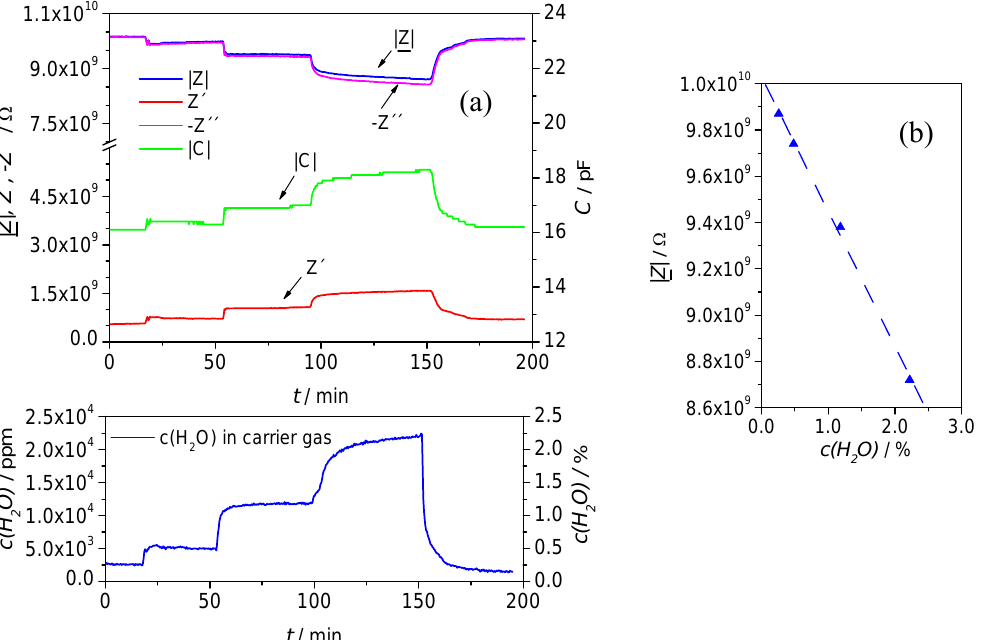
Figure 7. (a) Upper part: Impedimetric sensor signal (| Z |, Z´, -Z´´, C) of an IDE equipped with Fe-BTC in time-continuous measurements at 1 Hz for 0 - 2.5 vol%H Lower part: H O concentration in the test gas over time evaluated by FTIR. (b) Response 2 curve of the sensor (| Z | vs. c(H O)). At 120 °C a linear dependence of the complex 2 impedance from the humidity of the test gas was observed with a sensitivity of 590 M Ω /vol%H 2